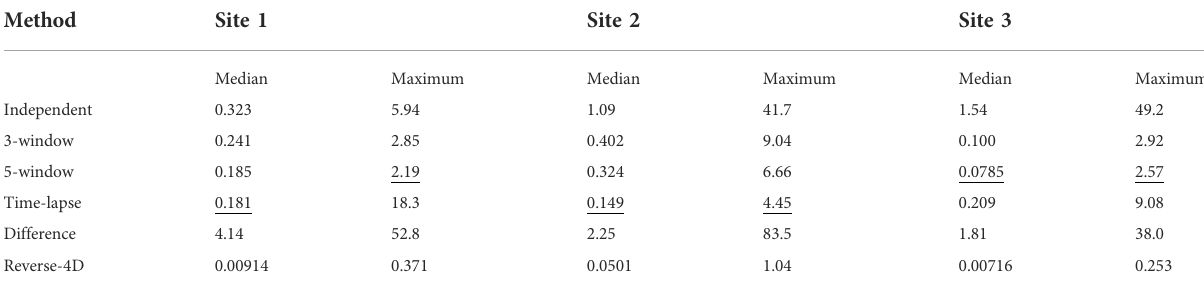
TABLE 3 Consistency measures of the tested inversion methods in terms of averaged percentage median and maximum differences. The method giving greatest consitency (smallest difference) is underlined for each measure and site.